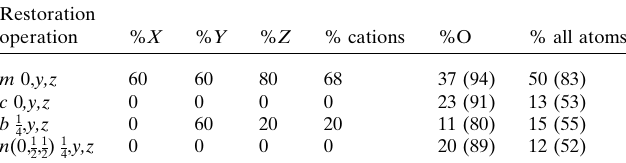
Table 9 Summary of the percentage of atomic quasi-restoration by the ð 1 (cid:2) 220 Þ twin plane in melilite for the admissible restoration operations (expressed in the basis of the twin). The values in parentheses are obtained by also taking into account the oxygen atoms restored with a degree of approximation between 1 and 1.5 A˚ . In the unit cell of the twin lattice, there are 20 cations of type X , 10 cations of type Y , 20 cations of type Z and 70 oxygen atoms, thus in total 120 atoms.